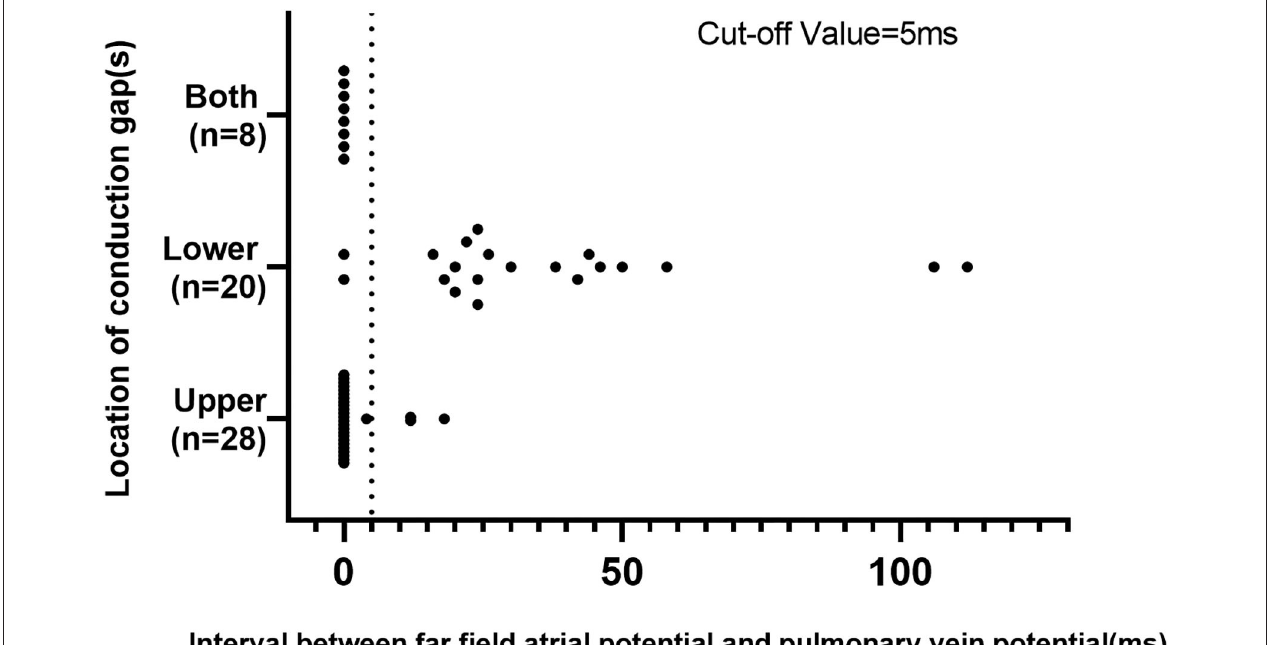
FIGURE 3 | Scatter plot of the cutoff value of the interval between far-field atrial potential and pulmonary vein potential in the validation cohort.